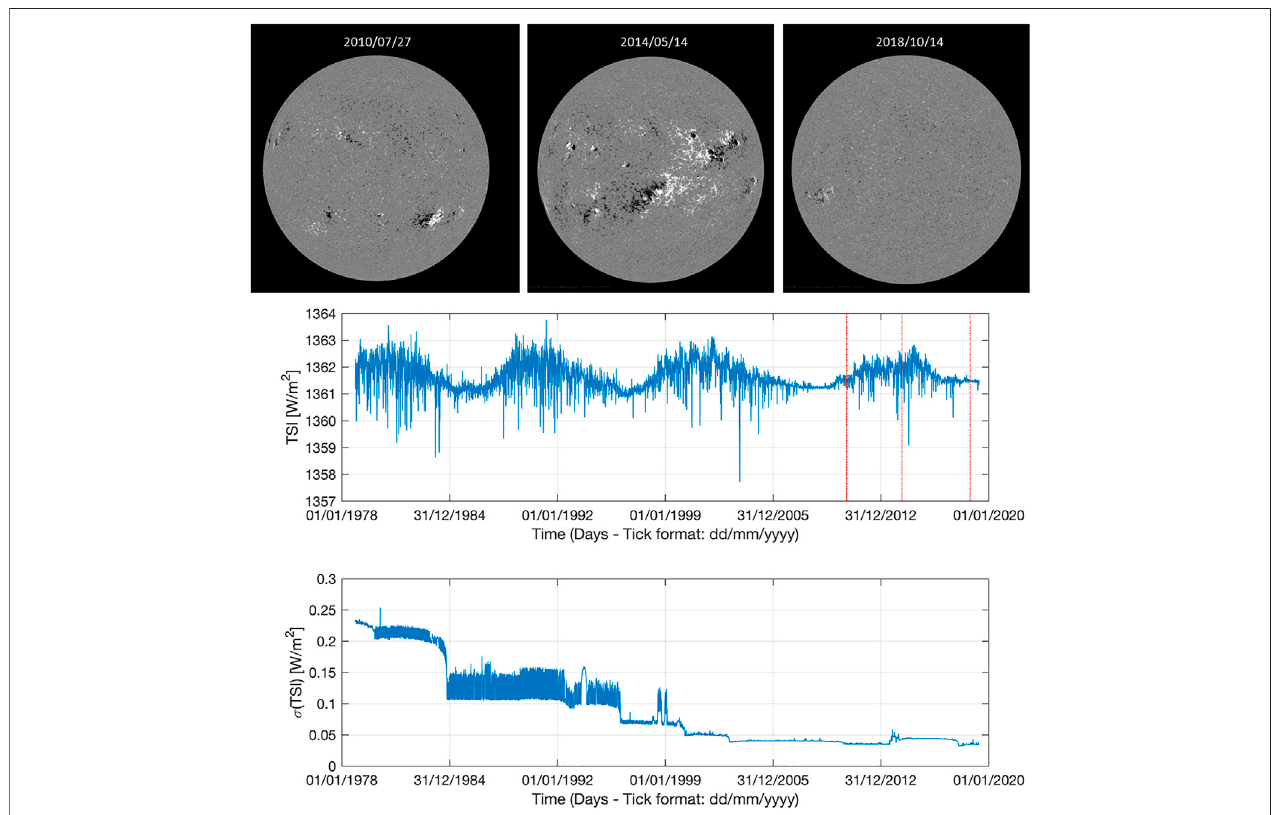
FIGURE 1 | HMI magnetogram from SDO (top) and community-consensus TSI composite 4 by Dudok de Wit et al. [15] (middle), where the red lines represent the TSI on the same dates as the HMI. The uncertainty reduction (bottom) re fl ects the increasing instrument accuracy from the